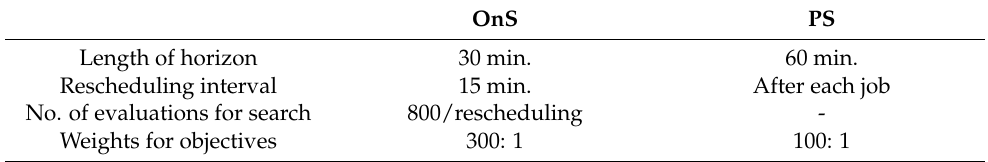
Table 3. Setting for the experiments. OnS PS Length of horizon 30 min. Rescheduling interval